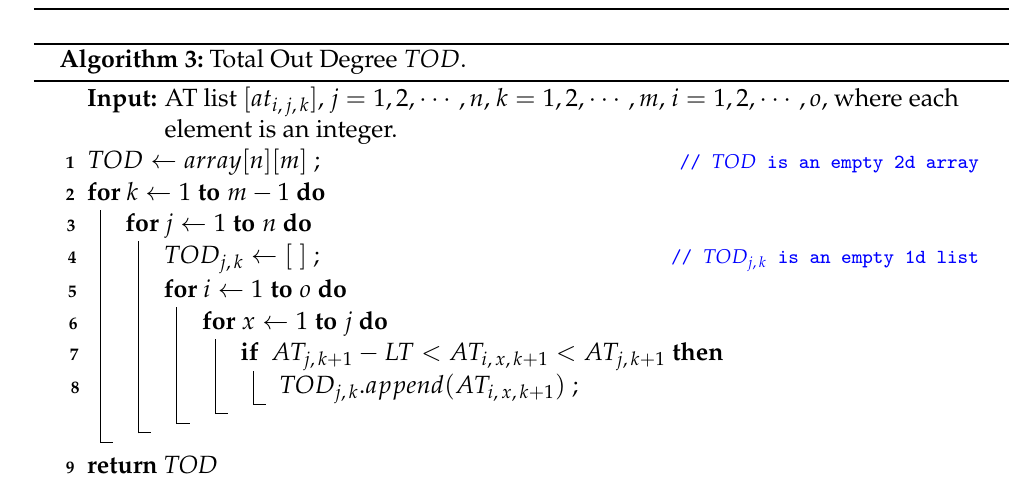
Algorithm 3: Total Out Degree TOD